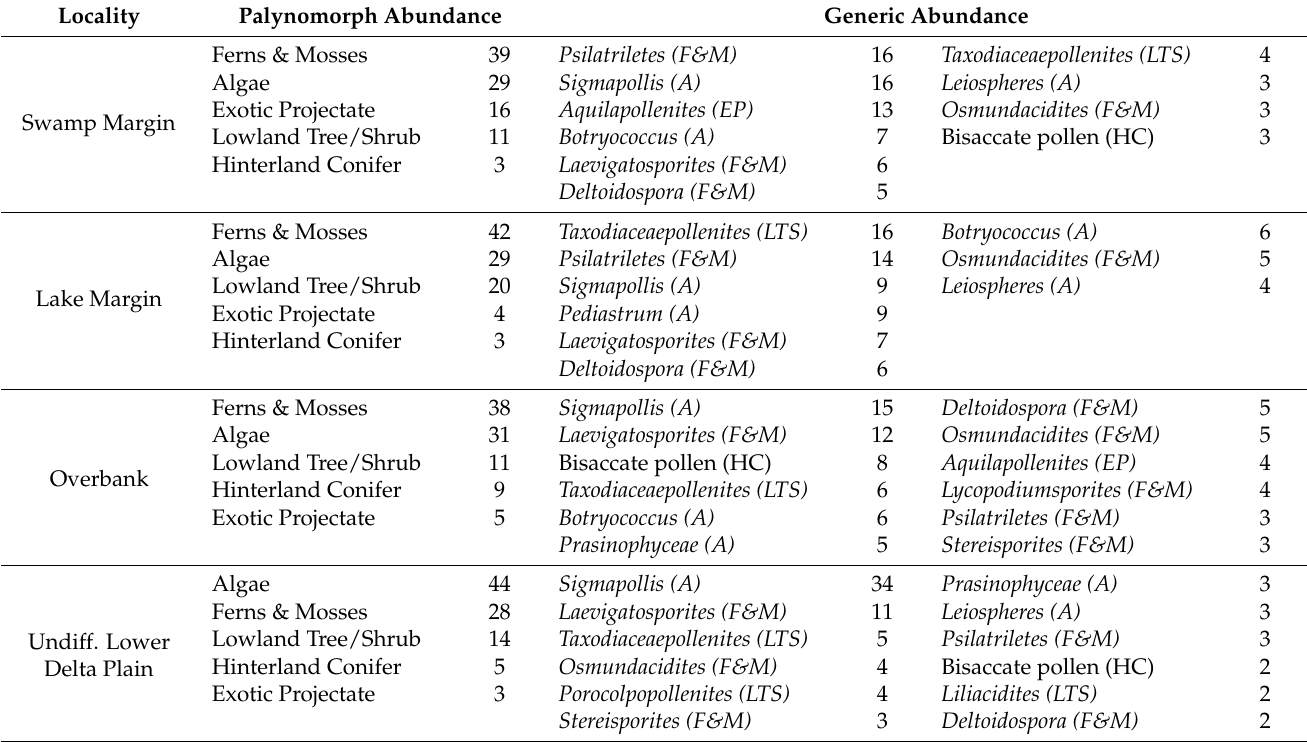
Table 3. Summary of the biotic composition of depositional environments. Abundance of ecological groups shown for groups with 2% or greater abundance. Generic abundances displayed for taxa comprising 75% of total fossil counts of each